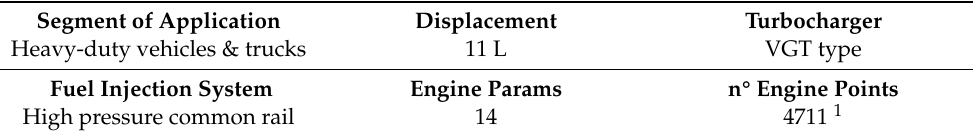
Table 1. Main engine parameters and test characteristics.